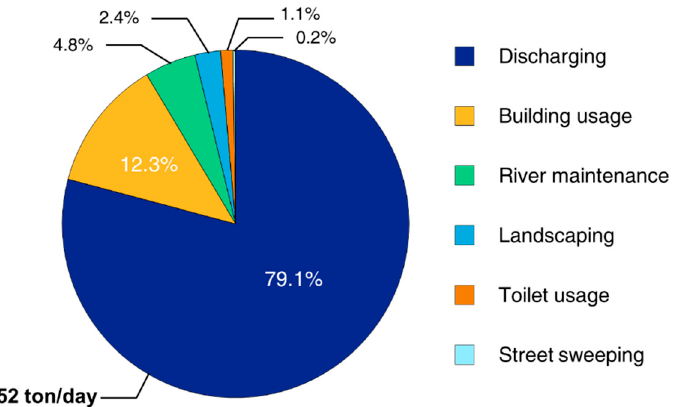
Figure 2. Utilization percentage of the inflowing groundwater in buildings (Seoul, South Korea).